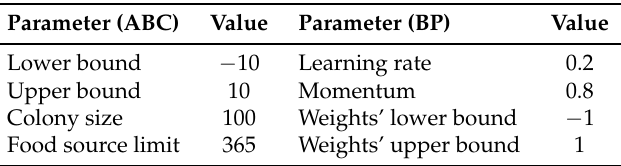
Table 2. ABC and back propagation (BP) parameters.